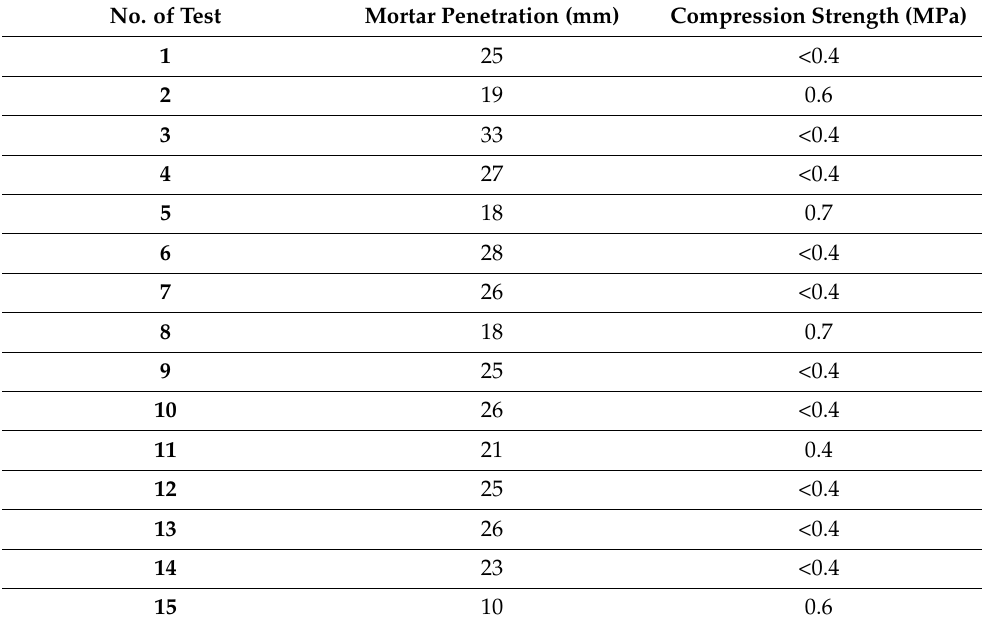
Table 3. Penetration test results on mortar.